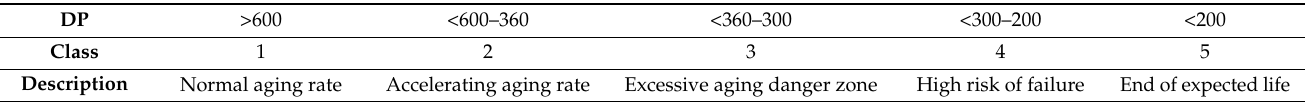
Table 1. The classification categories of the insulating paper state based on the degree of polymerization (DP) value and its description.